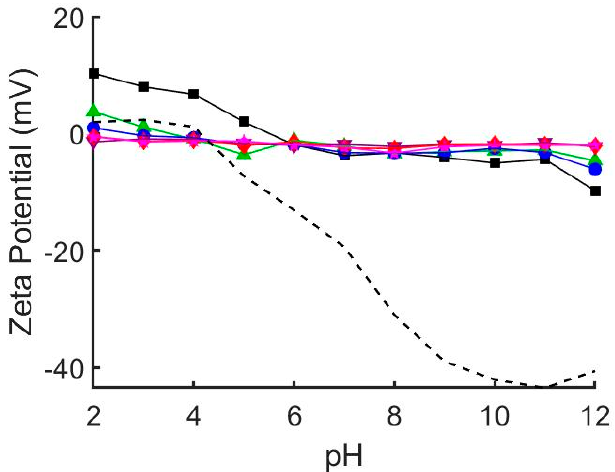
Figure 1. Zeta potential of glass beads (dashed line) and hybrid 1,2-dioleoyl-sn-glycero-3- phosphocholine (DOPC)/EO 22 Bd 33 vesicles at varying pH. 0 mol % polymer (black squares), 10 mol % polymer (green triangles), 25 mol % polymer (blue circles), 50 mol % polymer (purple inverted triangles), 75 mol % polymer (red diamonds), 100 mol % polymer (pink stars). The zeta potential of